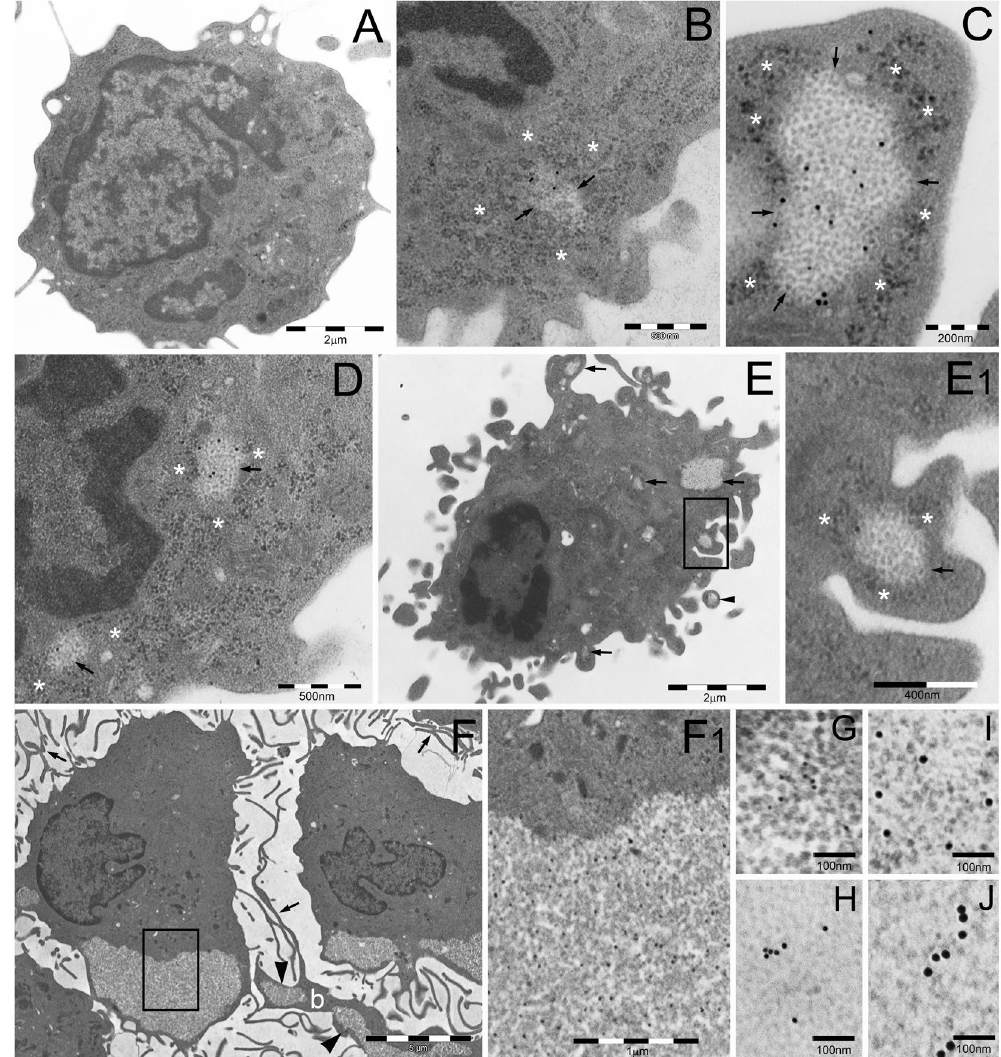
Figure 2. TEM analysis of PaCS development in IL4-DC. ( A ) Untreated human blood monocyte showing moderately developed cytoplasm with only a few organelles and cell protrusions. Cells treated with GM-CSF plus IL-4 for 24 h ( B,C ) or 48 h ( D,E ) showing early PaCS (arrowed borders) development inside ribosome- rich cytoplasmic areas in the absence of ER cisternae. Note FK1-reactive polyubiquitinated proteins ( B,E ) and 20 S ( C,D ) immunogold deposits in PaCS formed by moderately electron dense, barrel-like particles, to be compared with more dense and irregular, PaCS-sorrounding, ribosome particles (asterisks). The cell in ( E ) shows abundant cytoplasm with short hobnail-like protrusions and scattered PaCS (arrows); one of which (boxed) inside a protrusion is enlarged in (E1). Also note in ( E ) a detached PaCS-storing vesicle (arrowhead). Large PaCS are seen in DC after 5 days treatment with GM-CSF plus IL-4 ( F boxed area enlarged in F1 to show PaCS barrel-like particles with selective 20S immunogold reactivity). Note in ( F ) long and thin cell protrusions (arrows) typical of well-differentiated DC and a long bleb (b) filled with PaCS (arrowheads). 19S proteasome ( G 10 nm gold particles), HSP40 ( H , 15 nm), HSP70 ( I , 20 nm) and HSP90 ( J , 20 nm) immunoreactivity was found in enlarged portions of PaCS taken from sections adjacent to ( F